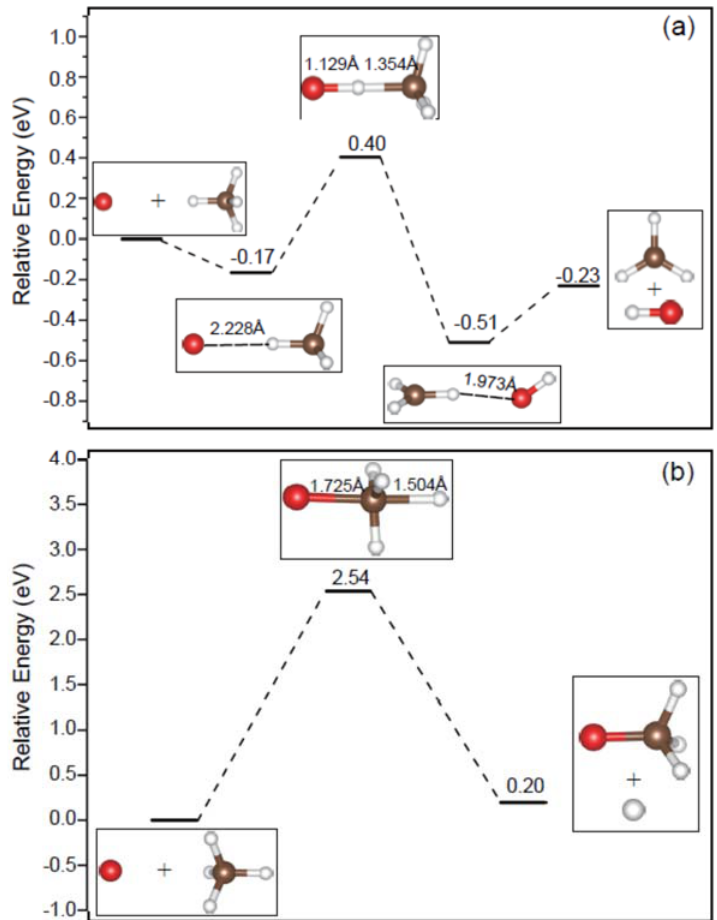
Figure 2. The reaction profiles for the attack of O − to CH 4 in the apex ( a ) and center-of-plane ( b ) attack modes.